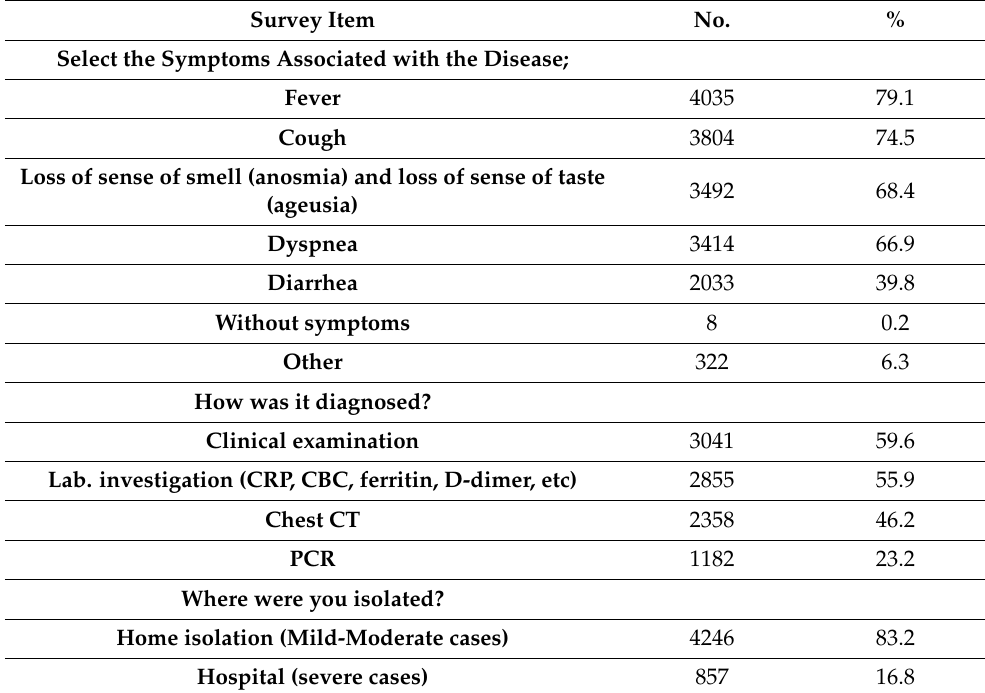
Table 2. Symptomatology, diagnostic measures, and place of isolation of COVID-19 patients ( n =